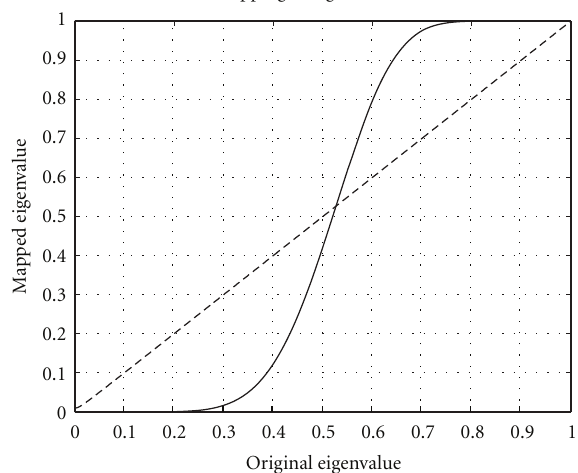
Figure 7: The transfer function that maps the eigenvalues of the structure